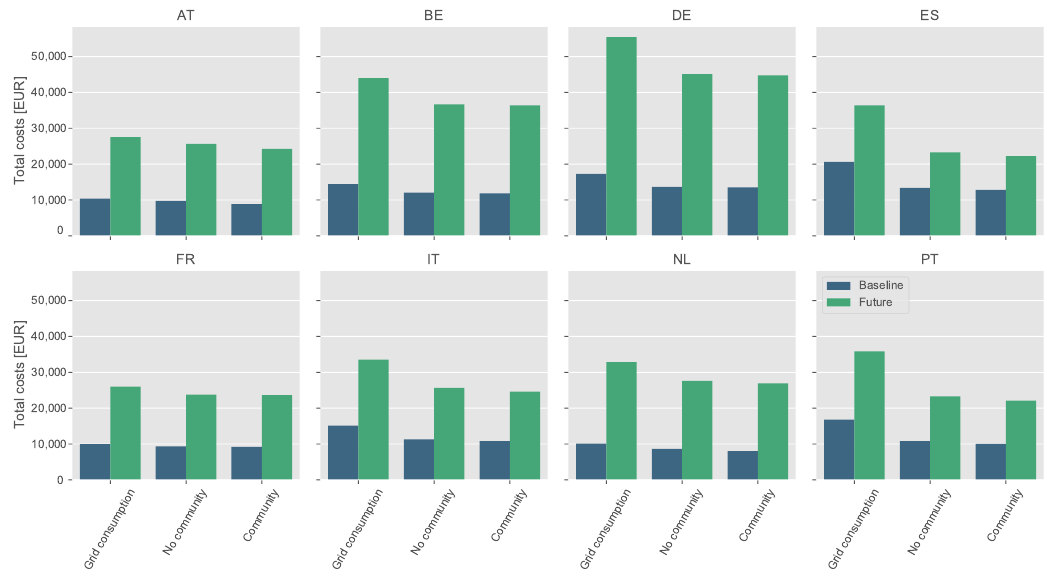
Figure 9. Total electricity costs in all countries.